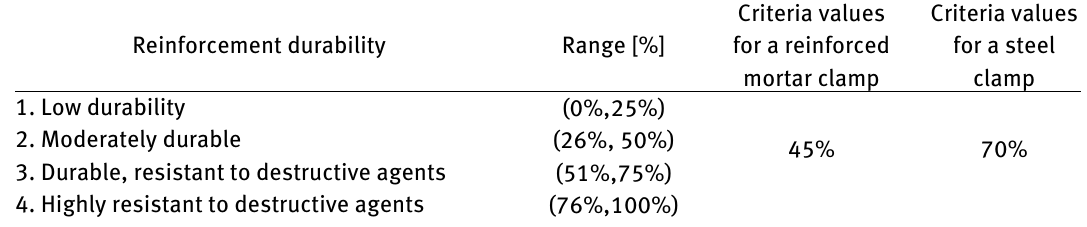
Table 6: Values for criterion: reinforcement durability (own studies)